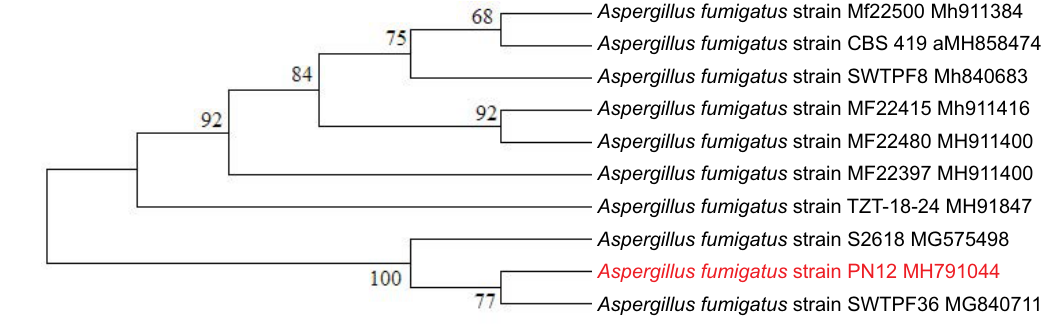
Fig. 1. Phylogenetic tree of strain